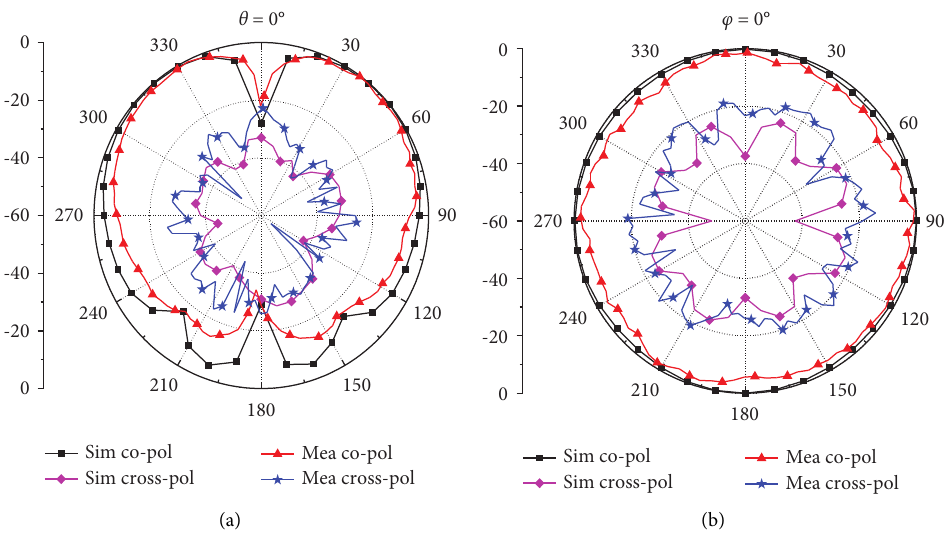
11 | of the proposed antenna.